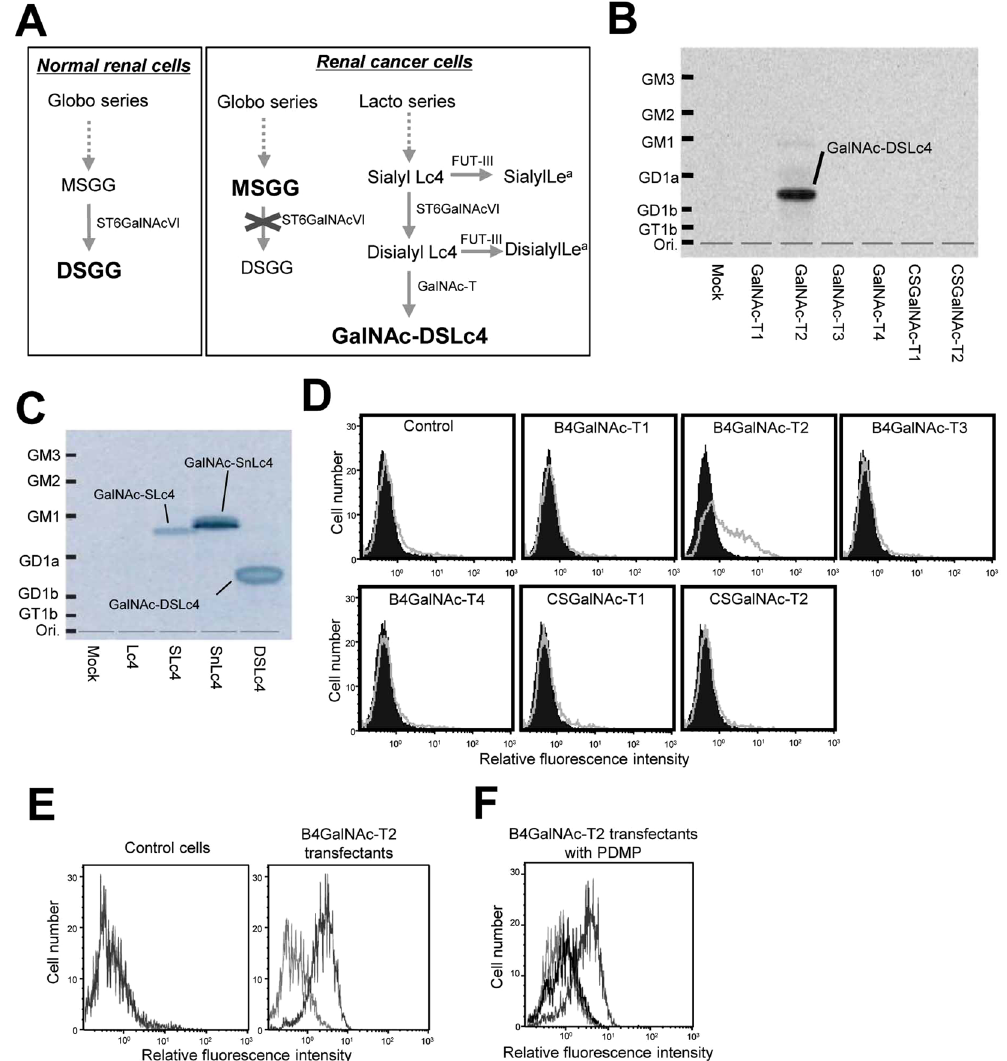
Figure 1. Synthetic pathway of renal cancer-related glycolipids, identification of B4GalNAc-T2 as a B4GalNAc-T responsible for the synthesis of GalNAc-DSLc4, and establishment of stable transfectants with surface expression of GalNAc-DSLc4. ( A ) Synthetic pathway of cancer related-glycolipids in normal renal cells or renal cancer cells. ( B ) TLC of the products from B4GalNAc-T2 enzyme assay. The N - acetylgalactosaminyltransferase assay was performed using the membrane fraction with DSLc4 as an acceptor substrate, and the products were analyzed by TLC and auto fluorography. The B4GalNAc-T2 is responsible for synthesis of GalNAc-DSLc4 using DSLc4 as an acceptor. ( C ) Substrate specificity of B4GalNAc-T2 transferase for lacto- or neolacto-series glycolipids. The N -acetylgalactosaminyltransferase assay was performed using lacto- and neolacto-series acceptors (Lc4, SLc4, SnLc4, and DSLc4). ( D ) Flow cytometric patterns of a RCC line (TUHR14TKB) transfected with individual cDNAs indicated. ( E ) Establishment of stable transfectants from VMRC-RCW cells. Surface expression of GalNAc-DSLc4 antigens in the transfectants by flow cytometric analysis using RM2 antibody. Gray profiles mean RM2-stained cells and light gray profiles mean negative cells. ( F ) Reduction of GalNAc-DSLc4 expression by D-PDMP treatment (for 6 days, conc. at 50 μ M). Black profiles mean reduced RM2 cells in flow cytometric